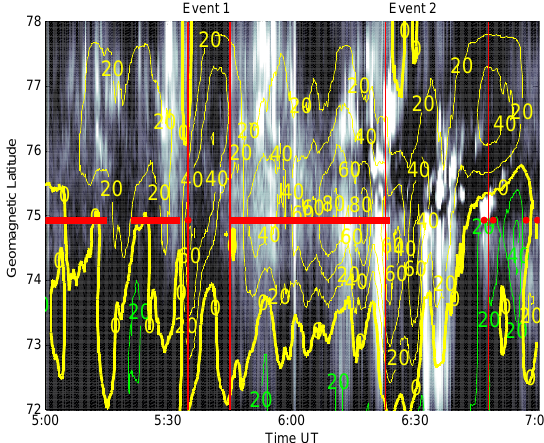
Fig. 5. Keograms along the magnetic meridian. The colour scale is in arbitrary units. Contour lines show ionospheric Hall current, A/km. Green contour lines show the eastward current and yellow contour-lines the westward current. The zero line is shown with a thick yellow line. A thick red line at the latitude of ESR indicates the times when ESR observed the more energetic precipitation of CPS-like character. Vertical red lines indicate the times of events 1 and 2. The y-axis shows geomagnetic